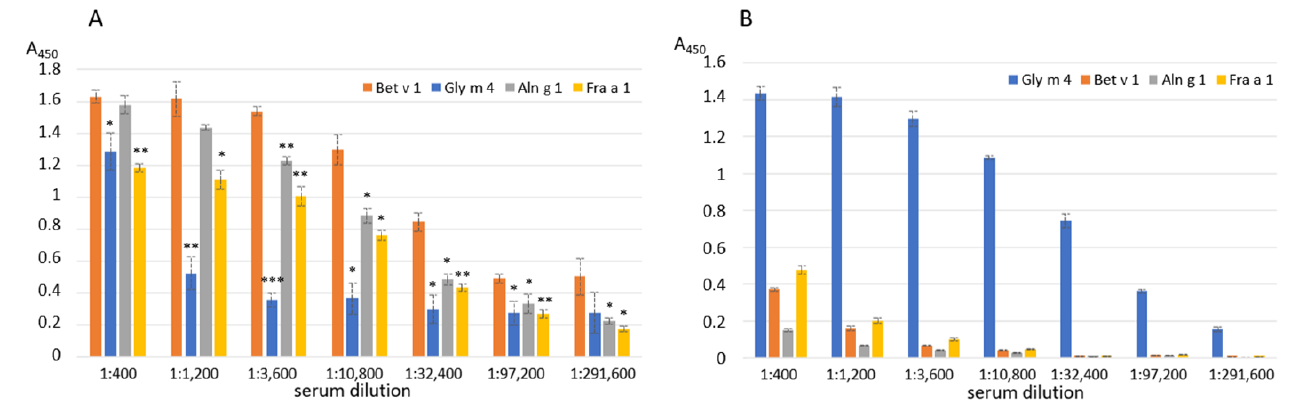
Figure 1. ELISA with the birch Bet v 1, the alder Aln g 1, the soybean Gly m 4 and the strawberry Fra a 1 using polyclonal rabbit anti-Bet v 1 ( A ) or rat anti-Gly m 4 ( B ) IgG. Error bars represent standard deviation between technical replications. Differences in mean A values between Bet v 1 ( A ) or Gly m 4 ( B ) and other allergens were compared by t -test (significance levels are: ( A ) * p < 0.05, ** p < 0.01, *** p < 0.005 ( A ); ( B ) p < 0.001 for Bet v 1, Aln g 1 and Fra a 3 in all serum